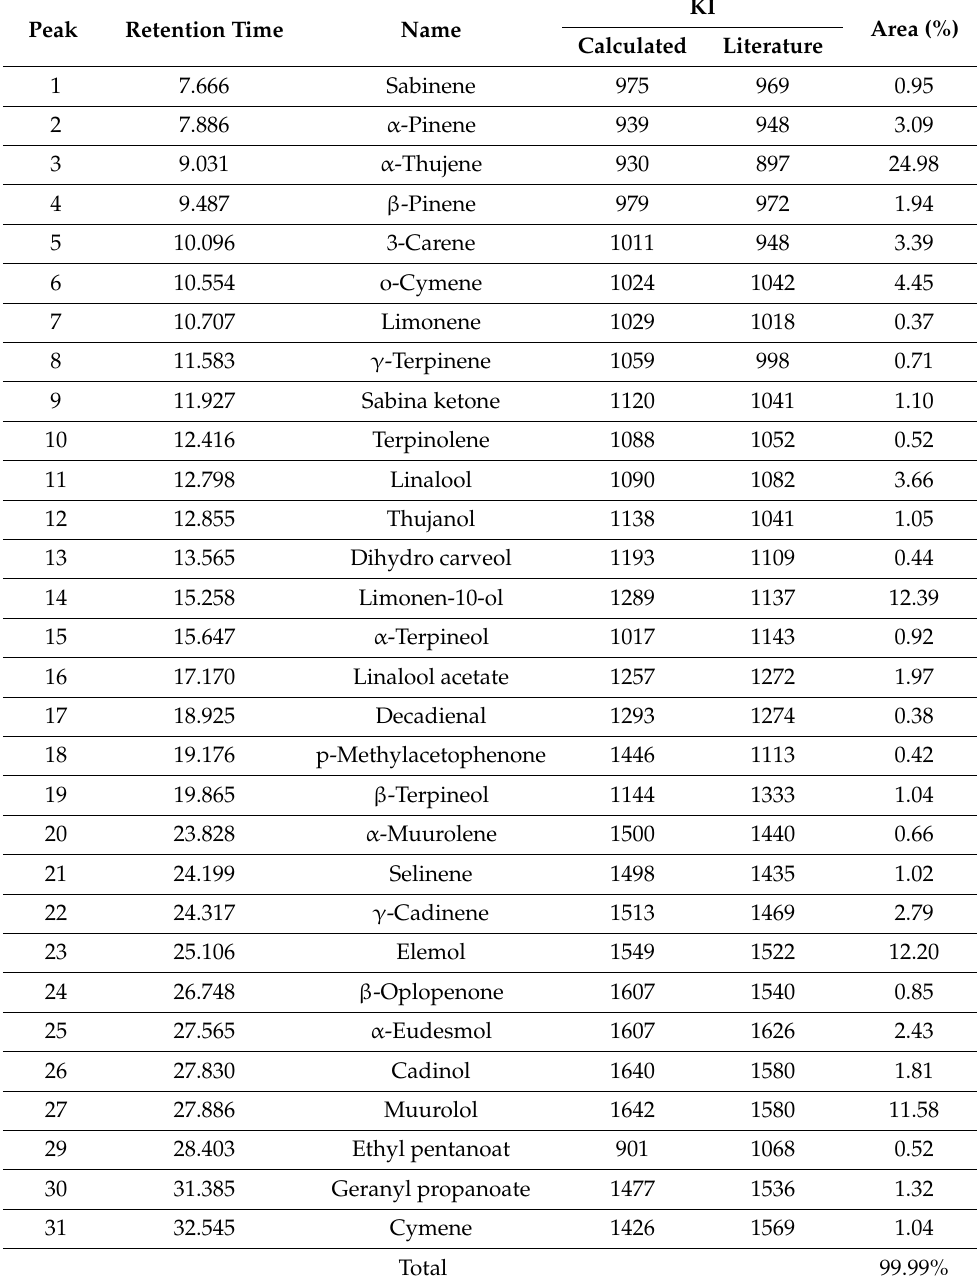
Table 1. Phytochemical compounds identified by GC/MS/MS in EOs of J. thurifera